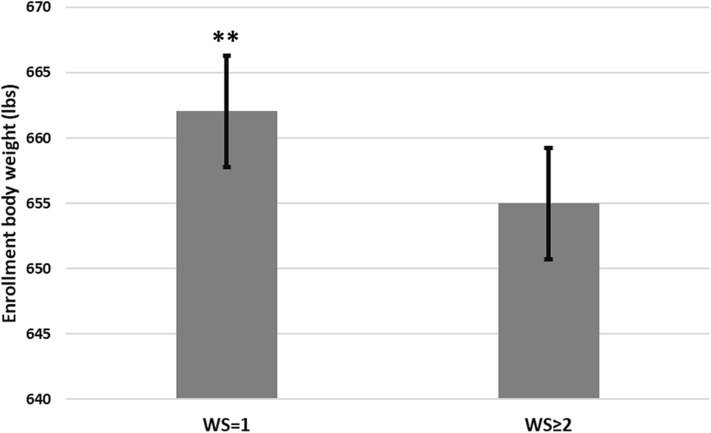
Body weight at enrollment between mixed-breed beef feedlot steers meeting the case definition* of bovine respiratory disease (BRD) with a Whisper Score (WS) of 1 compared to steers with a WS ≥ 2. Error bars denote 95% confidence intervals. *The BRD case definition consisted of an animal displaying a clinical illness score of 1–3 and a rectal temperature of >102.5° F and <103.9° F. A WS was subsequently captured and calves were stratified by WS = 1 or >2. **A statistical difference of P < 0.05.